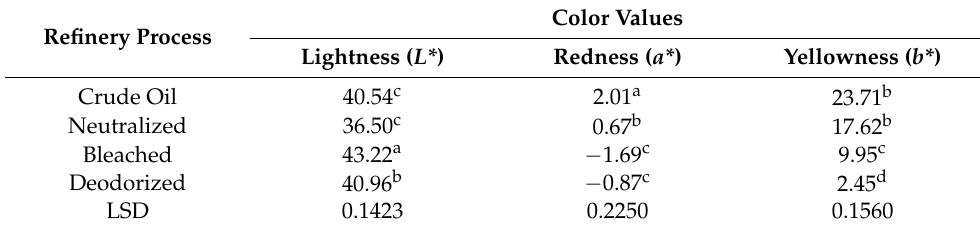
Table 9. Color values after refining process of nut oil